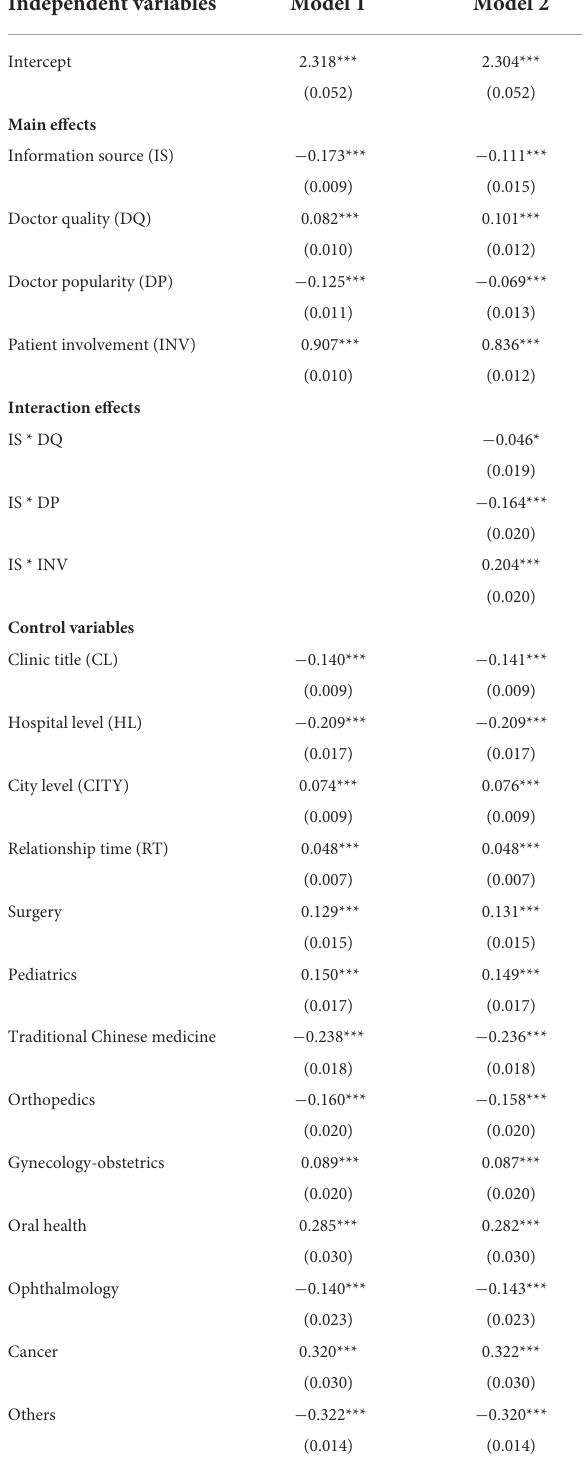
TABLE 4 Results for the effects of determinants on treatment effect satisfaction.